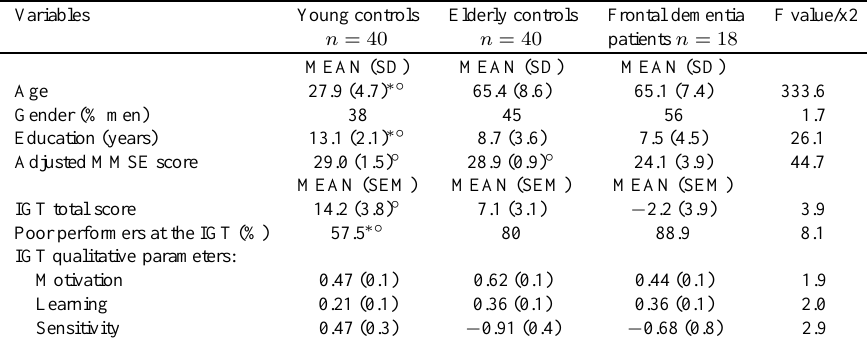
Sociodemographic and neuropsychological features and gambling task parameters of the three study groups